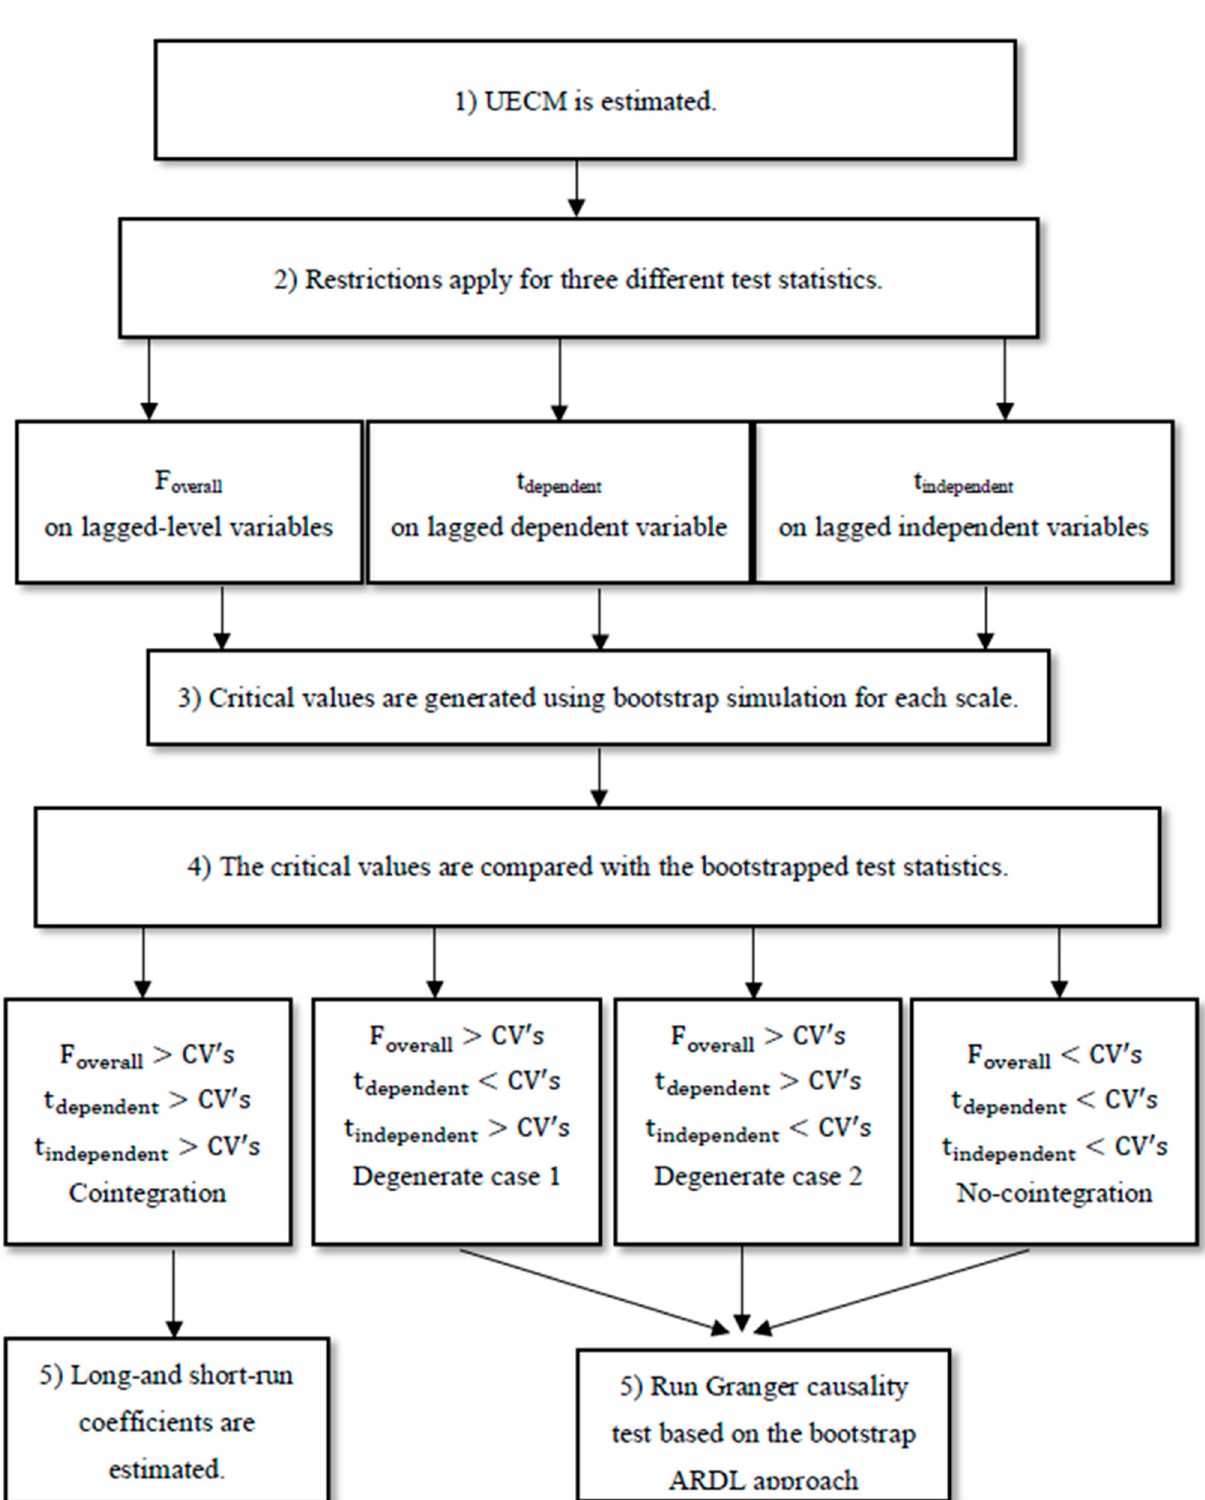
Figure A1. A. flow chart of the stages of the bootstrap ARDL approach.